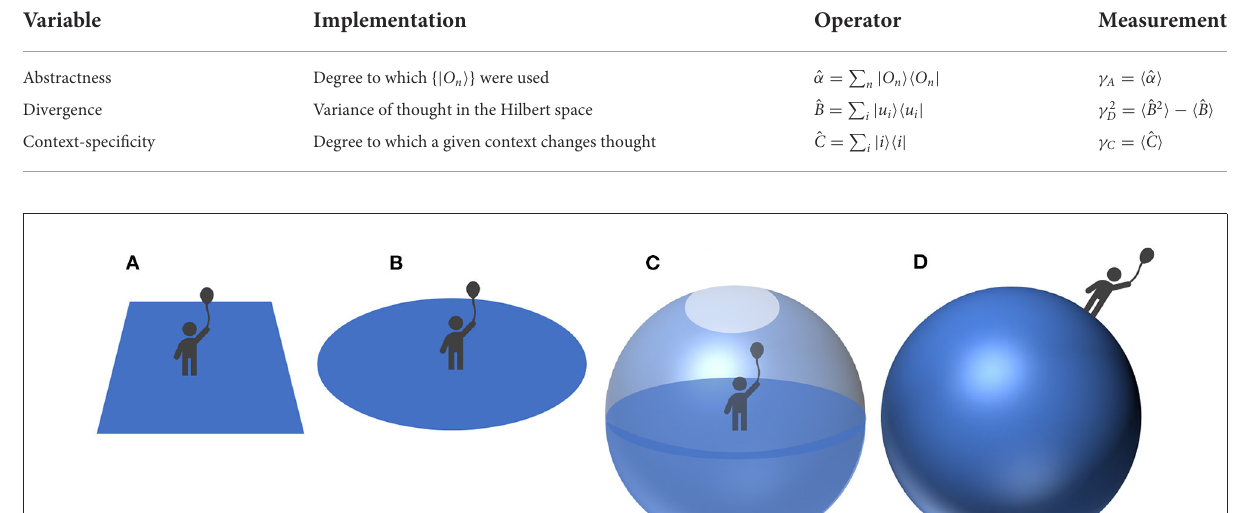
TABLE 3 Summary of the mathematical forms of the variables.